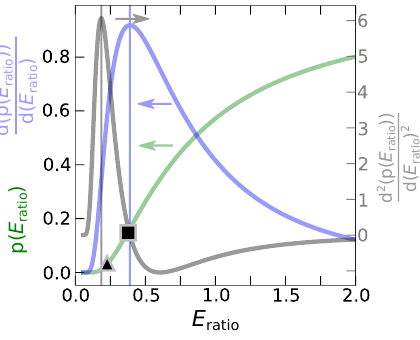
) along the direction of constant Figure 7: Endoergic SE fraction p ( E ratio / k = 1.6 (cid:181) K . The green line represents the fit function energy for E tot B ) = − 1.29 / ( 1 − 2.29 e 0.35 x − 1.43 ) of the endoergic fraction along the constant f ( E ratio energy axis calculated by Eq. 3. Blue and grey lines show the first and second deriva- tives of the fit function. The maximum sensitivity at an endoergic SE fraction of 0.15 (0.03) for the left (right) side of the d is illustrated as a black square and triangle. Bures The vertical lines mark the maxima of the